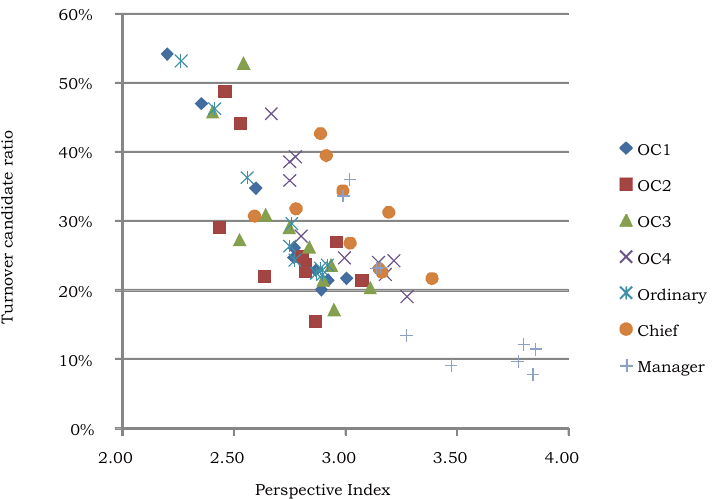
Figure 6. Perspective index by occupational and rank categories and annual transitions in turnover candidate